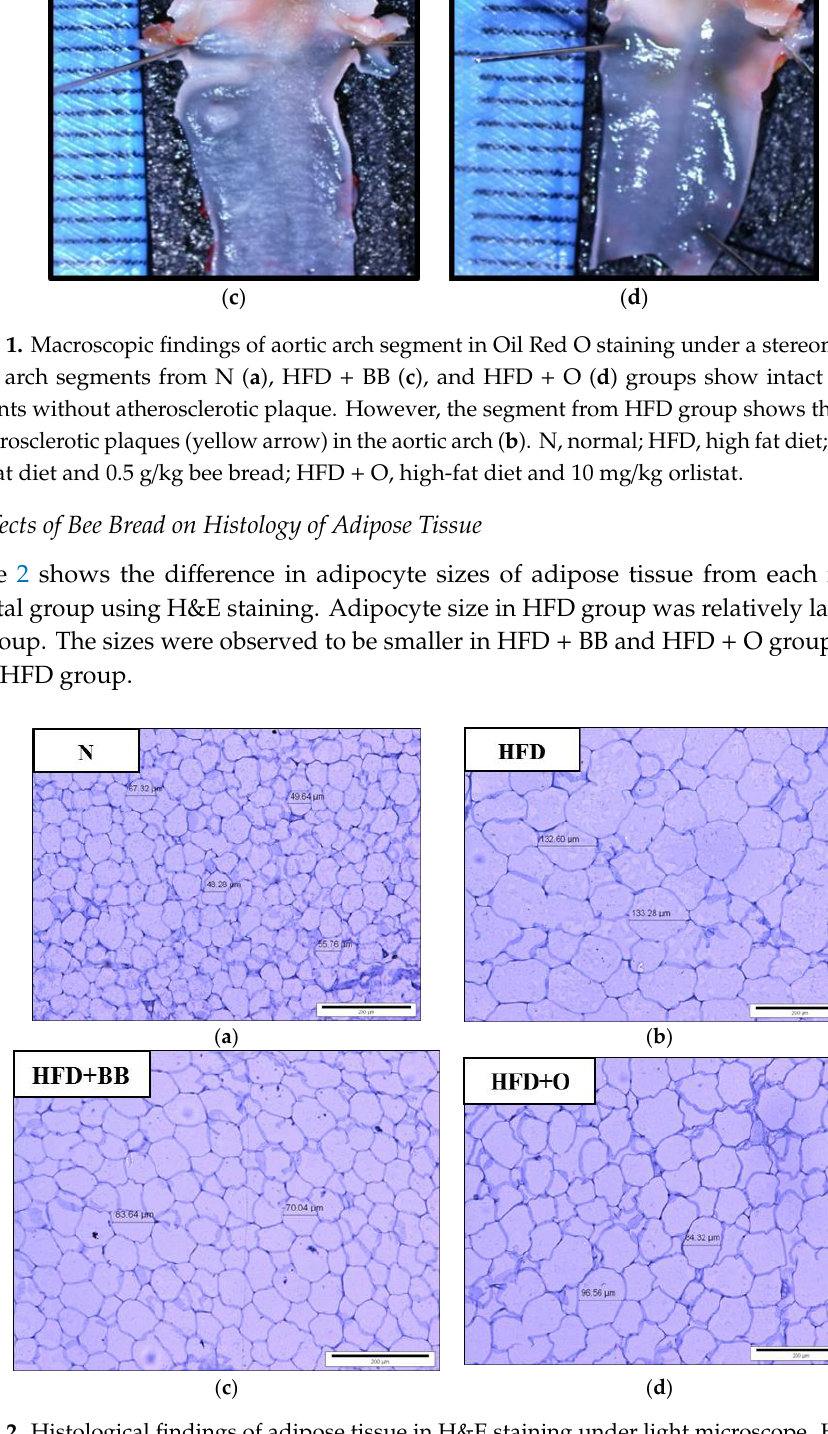
Figure 2. Histological findings of adipose tissue in H&E staining under light microscope. HFD group ( b ) has relatively larger adipocyte size compared to N group ( a ). Both HFD + BB ( c ) and HFD + O ( d ) groups had relatively smaller adipocyte size compared to the HFD group. N, normal; HFD, high fat diet; HFD + BB, high-fat diet and 0.5 g / kg bee bread; HFD + O, high-fat diet and 10 mg / kg orlistat. (Magnification × 200, Haematoxylin and Eosin